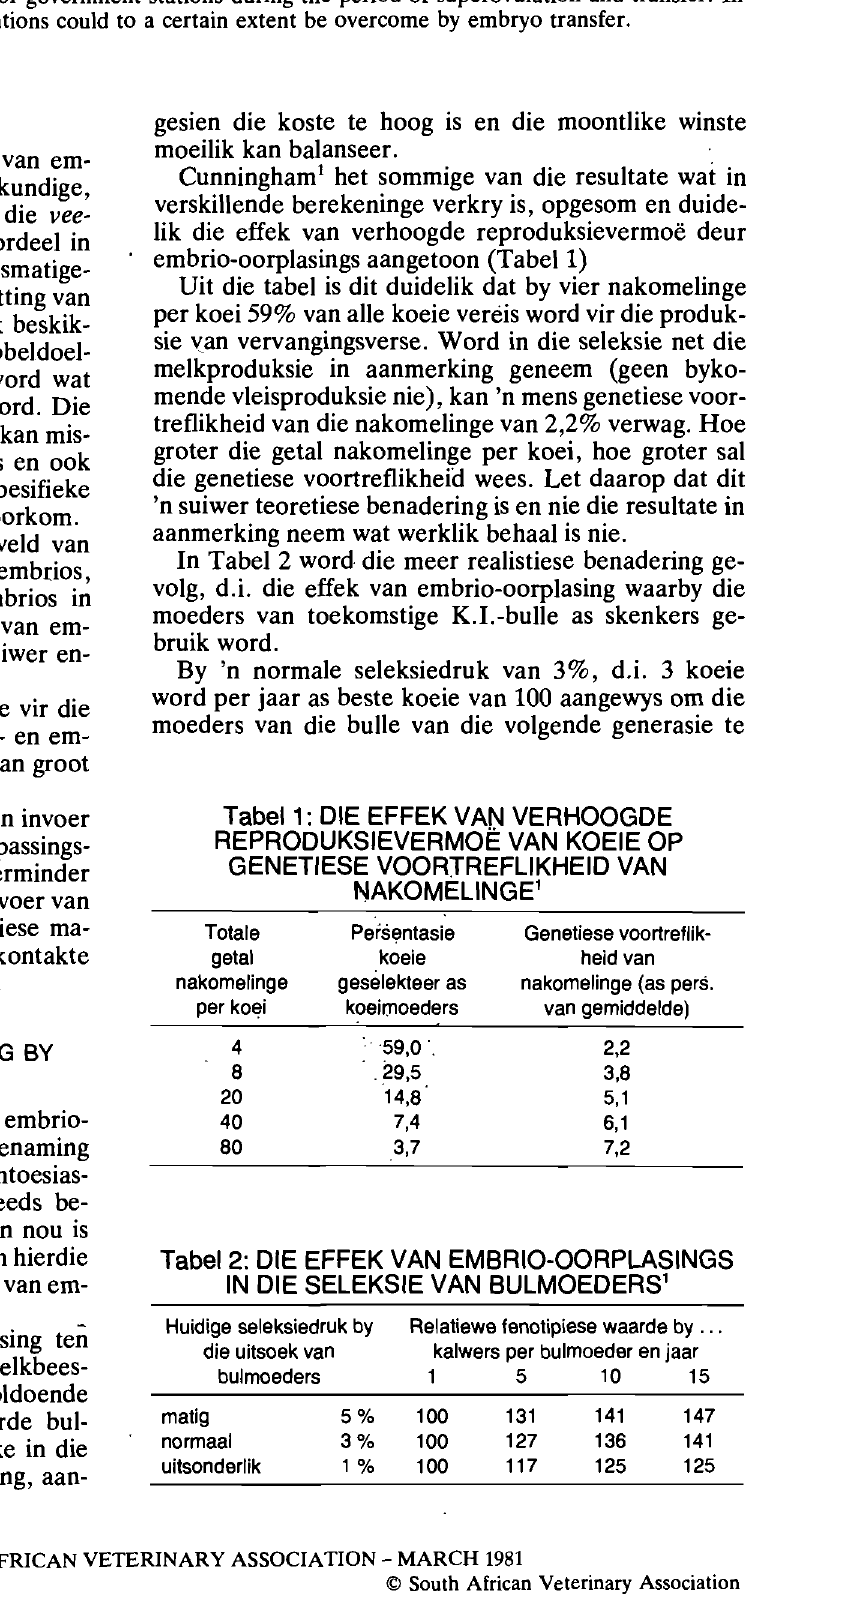
Tabel2: DIE EFFEK VAN EMBRIO-OORPLASINGS IN DIE SELEKSIE VAN BULMOEDERS 1 Huidige seleksiedruk by die uitsoek